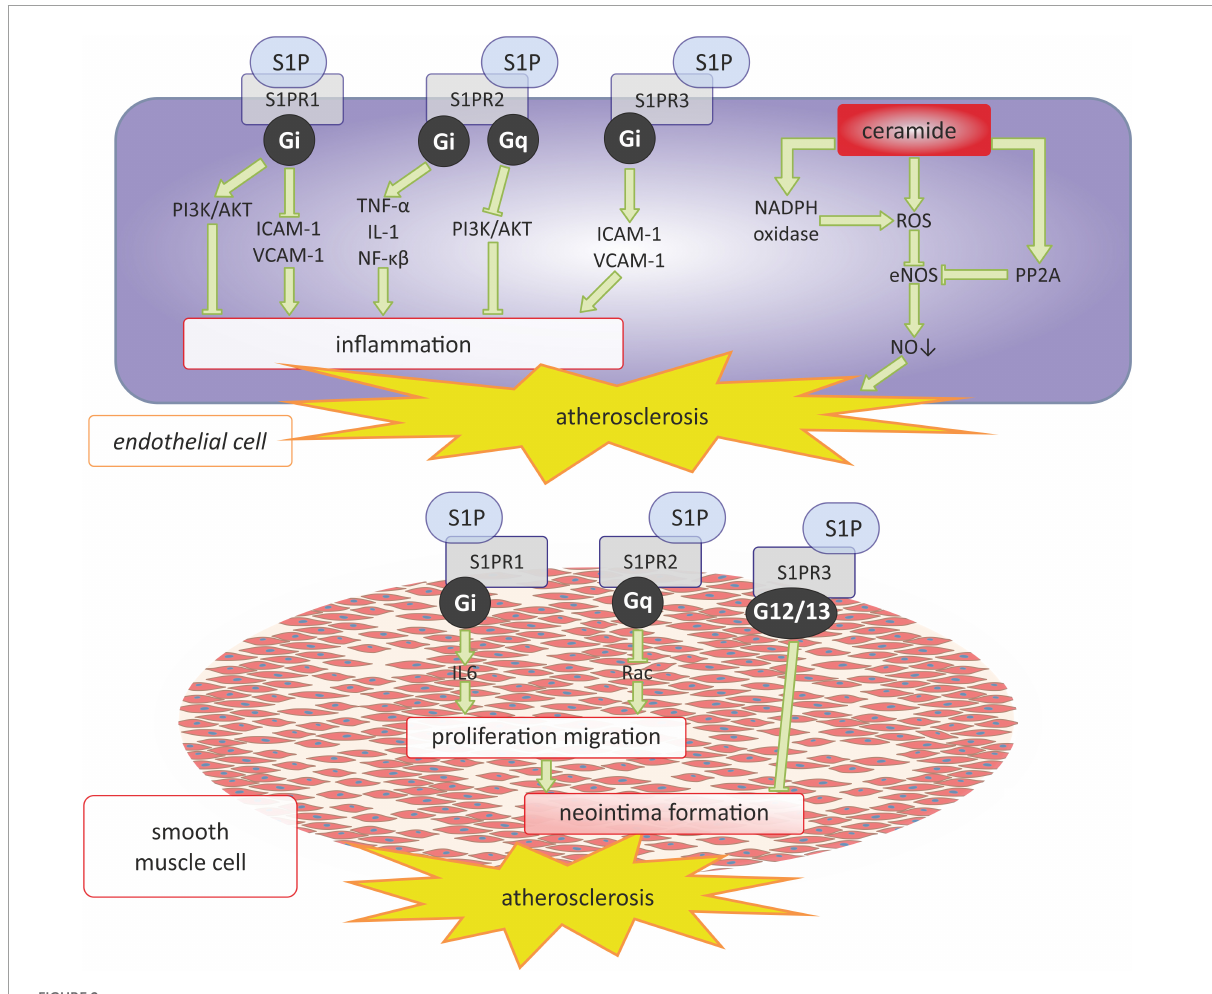
FIGURE2 Sphingosine 1-phosphate and ceramide signaling in atherosclerosis. AKT, serine/threonine protein kinase B; eNOS, endothelial nitric oxide synthase; G i , G i protein alpha subunit; G q , G q protein alpha subunit; ICAM-1 -intercellular adhesion molecule 1; IL-1, interleukin 1; IL-6, interleukin 6; NADPH oxidase, nicotinamide adenine dinucleotide phosphate oxidase; NF- κ B, nuclear factor kappa-light-chain-enhancer of activated B cells; NO, nitric oxide; PI3K, phosphoinositide 3-kinase; PP2, protein phosphatase 2, Rac, family small GTPase; ROS, reactive oxygen species; S1P, sphingosine-1-phosphate; S1PR1, sphingosine-1-phosphate receptor 1; S1PR2, sphingosine-1-phosphate receptor 2;